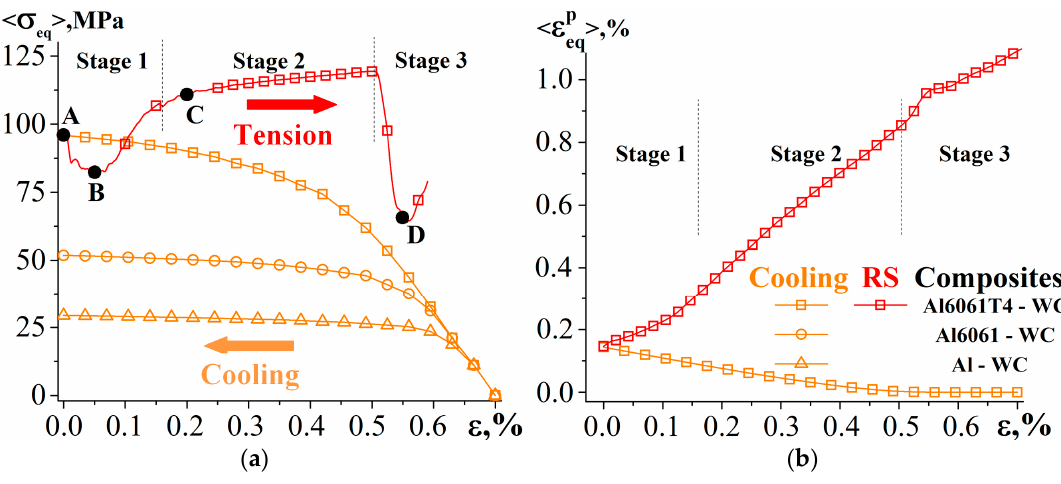
Figure 8. Stress–strain curves under cooling of composites with different matrices and under sub- sequent tension of the Al6061T4-WC composite ( a ). Homogenized accumulated equivalent plastic strain in the matrix of the Al6061T4-WC composite under cooling and subsequent tension ( b ). After cooling, the level of residual stresses increases with the yield stress (Figure 8a).